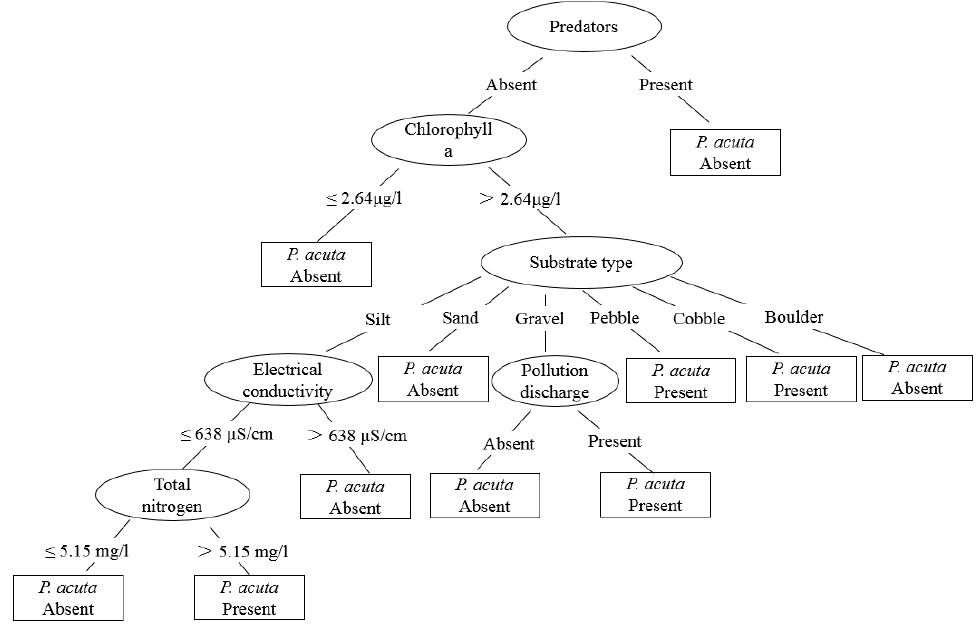
Figure 5. Classification tree model predicting the presence or absence of Physella acuta.